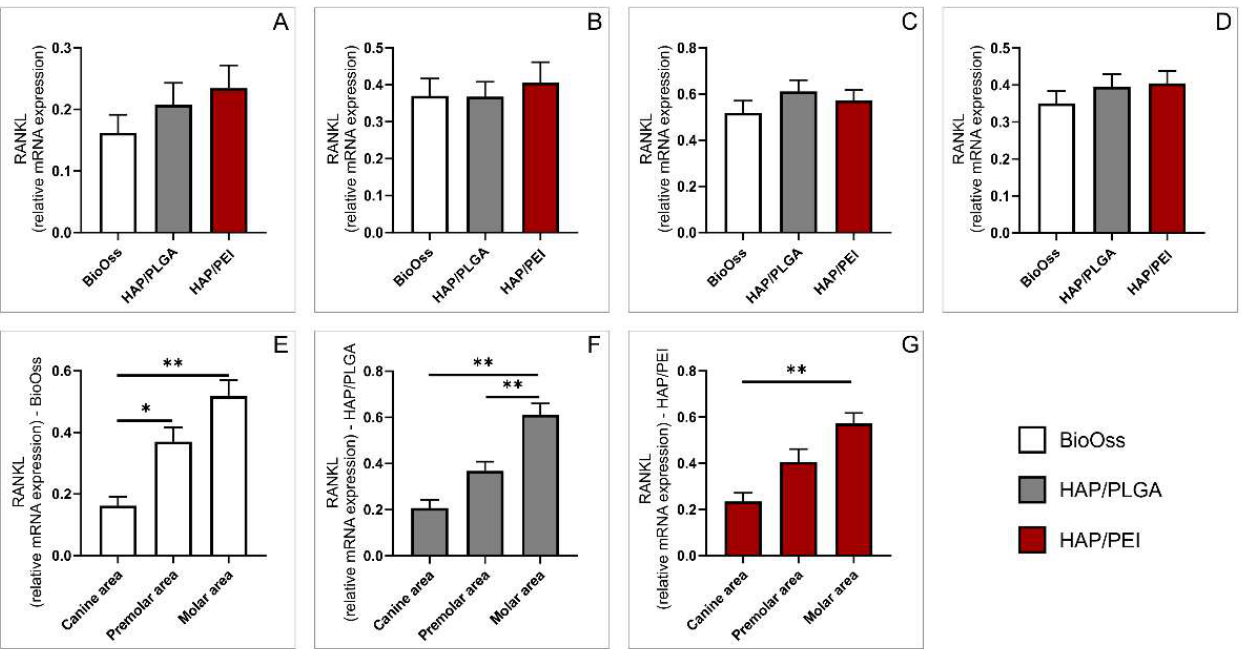
Figure 6. Relative expression of RANKL gene: ( A ) canine area, ( B ) premolar area, ( C ) molar area, ( D ) whole mandibula, ( E ) BioOss graft, ( F ) HAP/PLGA graft, ( G ) HAP/PEI graft. The values are mean ± standard error of the mean (SEM), * denotes a significant difference p < 0.05, ** denotes a significant difference p < 0.01.